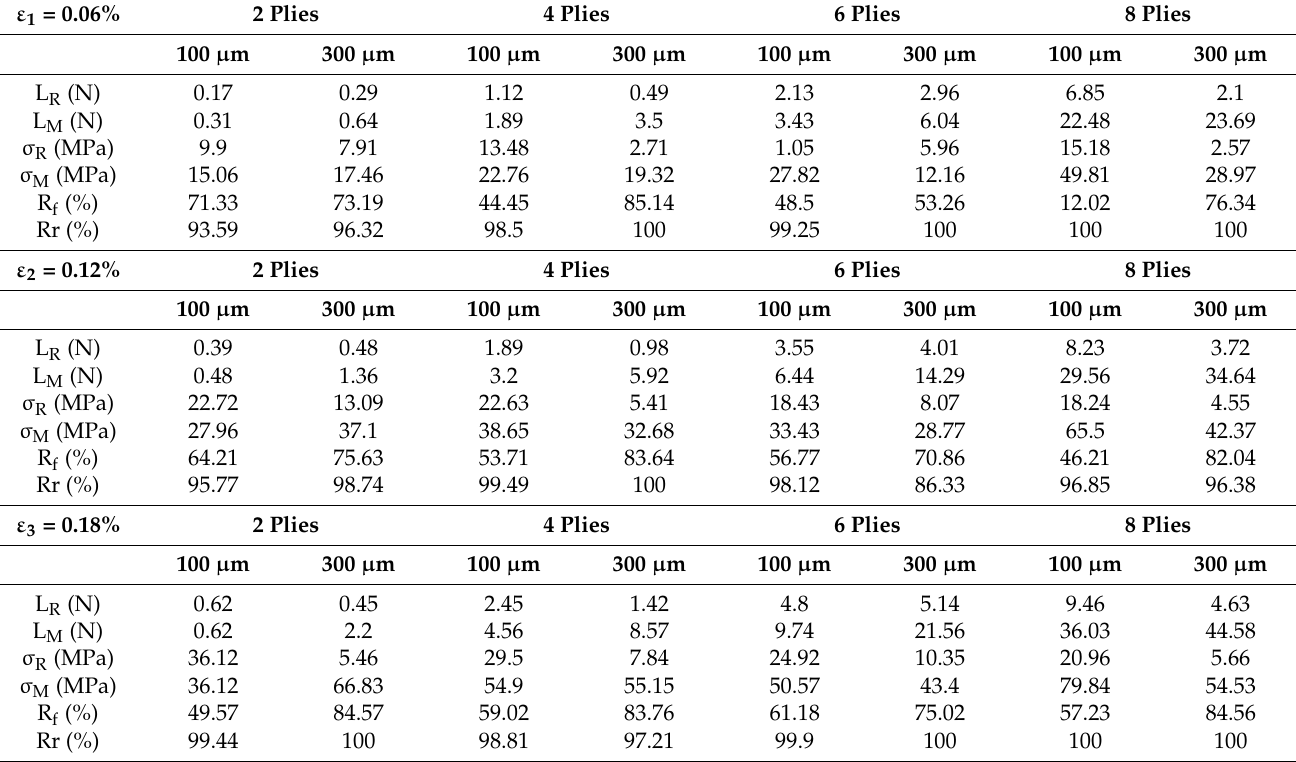
Table 3. SM data from single thermo-mechanical cycles at increasing